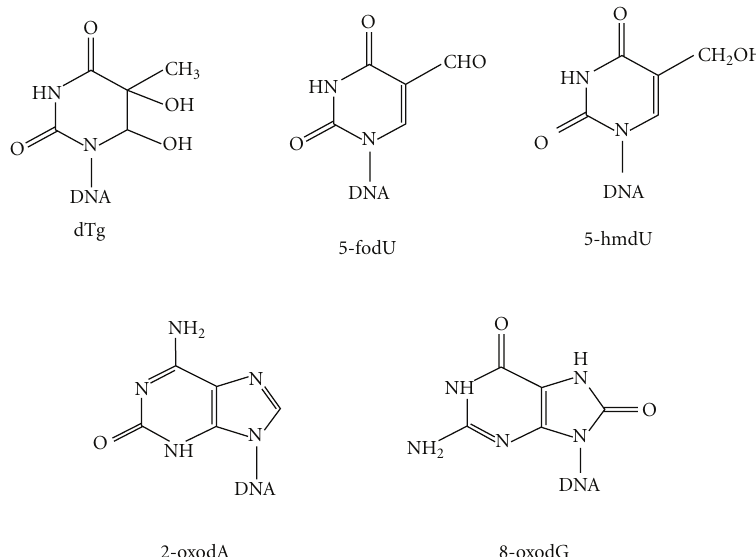
Figure 1: The structures of the studied oxidatively damaged bases, thymine glycol (dTg), 5-formyluracil (5-fodU), 5-hydroxymethyluracil (5-hmdU), 1,2-dihydro-2-oxoadenine (2-oxodA), and 7,8-dihydro-8-oxoguanine (8-oxodG).